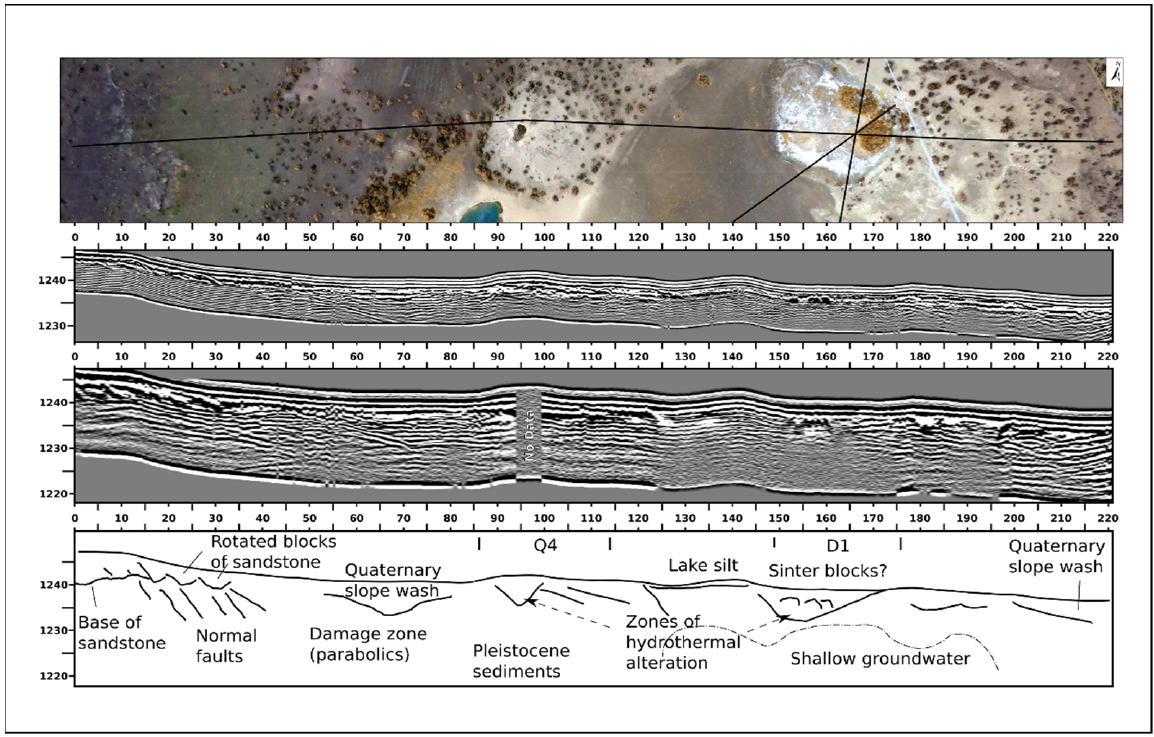
Figure 17. GPR transect 1 from west to east, descending from the silicified sandstone outcrop, across feature Q4 and D1, and terminating at the east fence of the ACEC. (Figure S1: GPR raw data and topographically corrected data for Track 1, 50 MHz. Figure S2: GPR raw data and topographically corrected data for Track 1, 100 MHz).